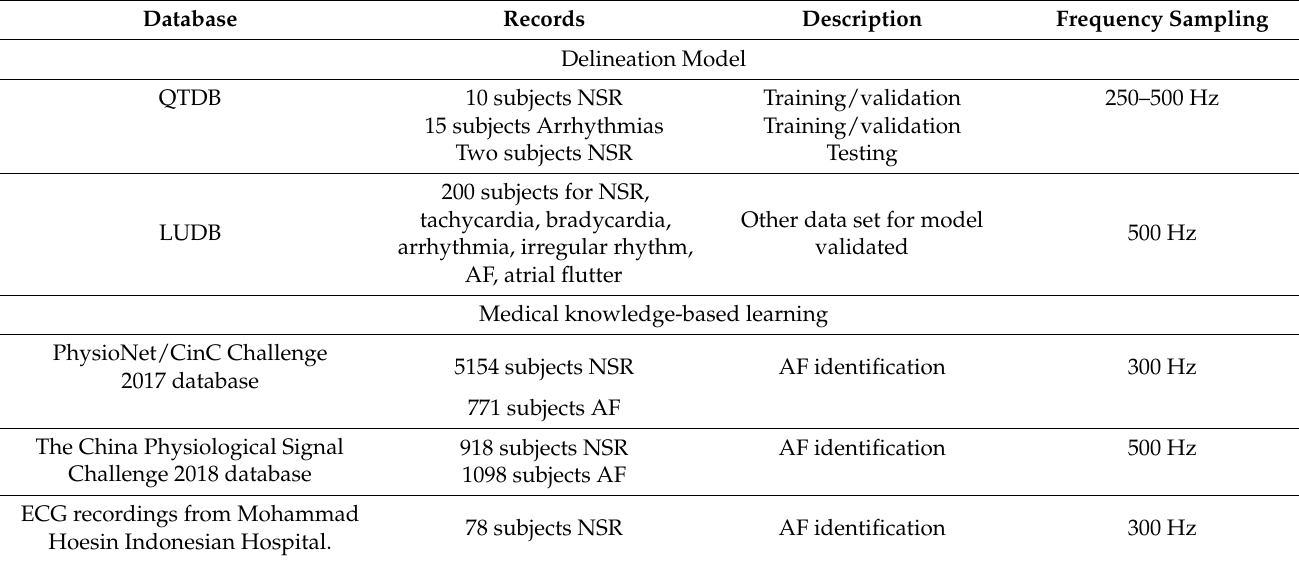
Table 1. The data distribution for the delineation and identification